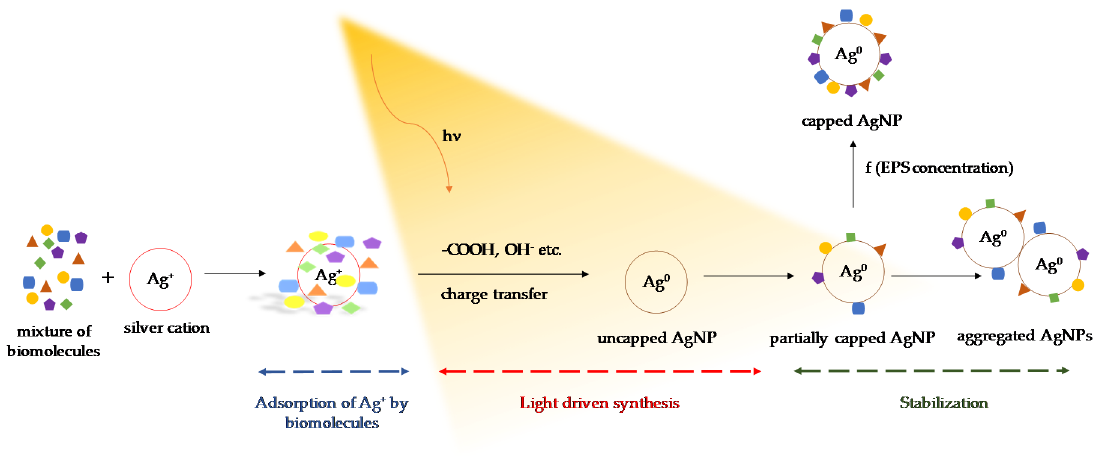
Figure 12. The proposed three-step mechanism of AgNP synthesis using EPS of C. reinhardtii .